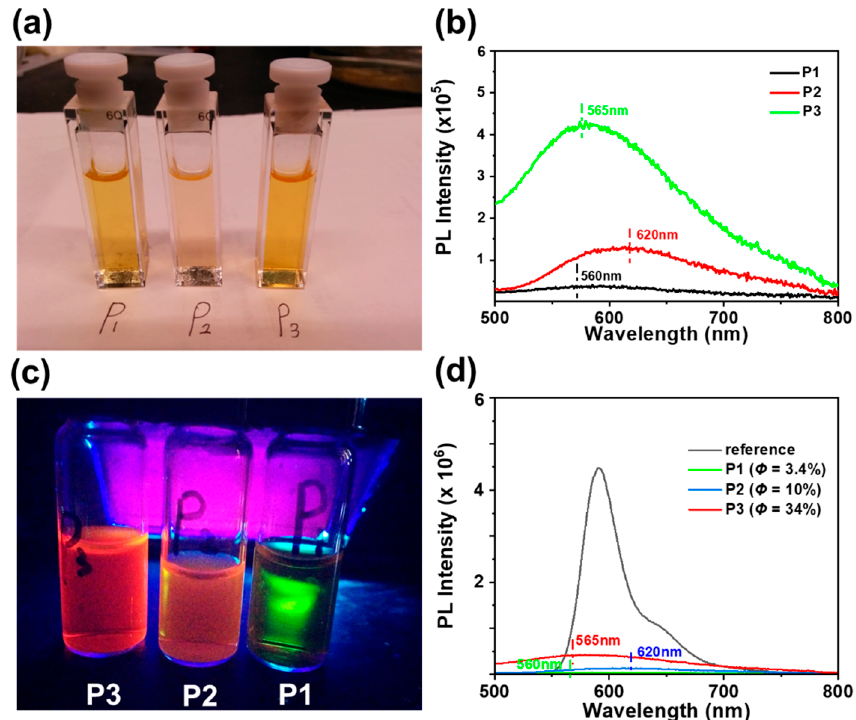
Figure 4. ( a ) The photograph of P1, P2 and P3 (0.016 mg/mL) solutions. ( b ) The PL intensity of P1, P2 and P3 in H 2 O with the concentration of 0.016 mg mL − 1 . ( c ) The fluorescence photograph of P1, P2 and P3 in H 2 O (5 mg/mL). ( d ) The integrated emissions of P1, P2 and P3 in H 2 O are used for the fluorescence quantum yield calculation with the concentration of 0.016 mg/mL.